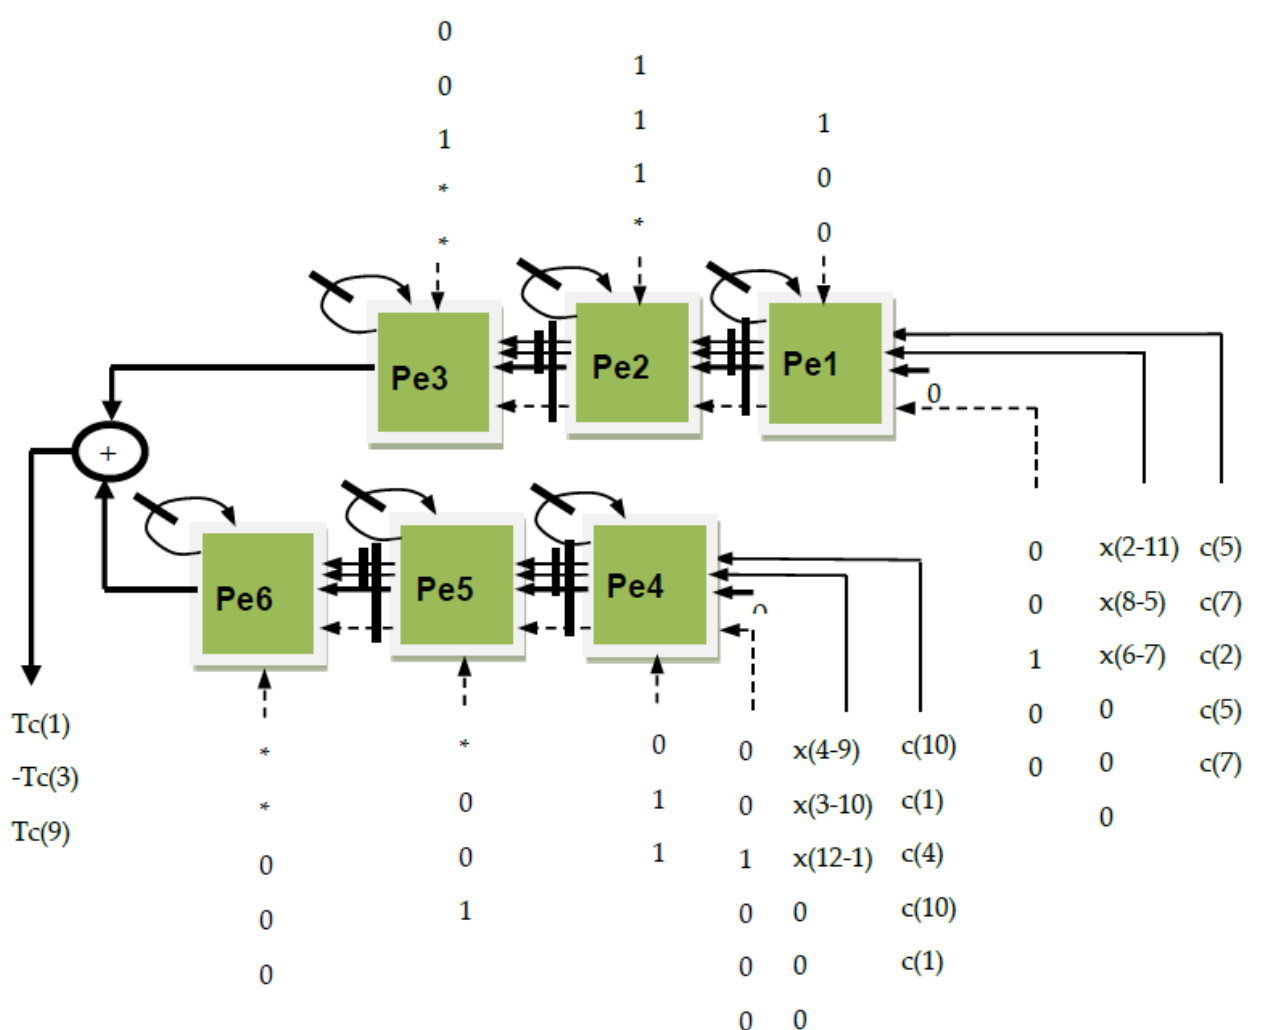
Figure 5. The VLSI architecture of the hardware core that implements Equation (12), where * marks a delay of one clock cycle [26].